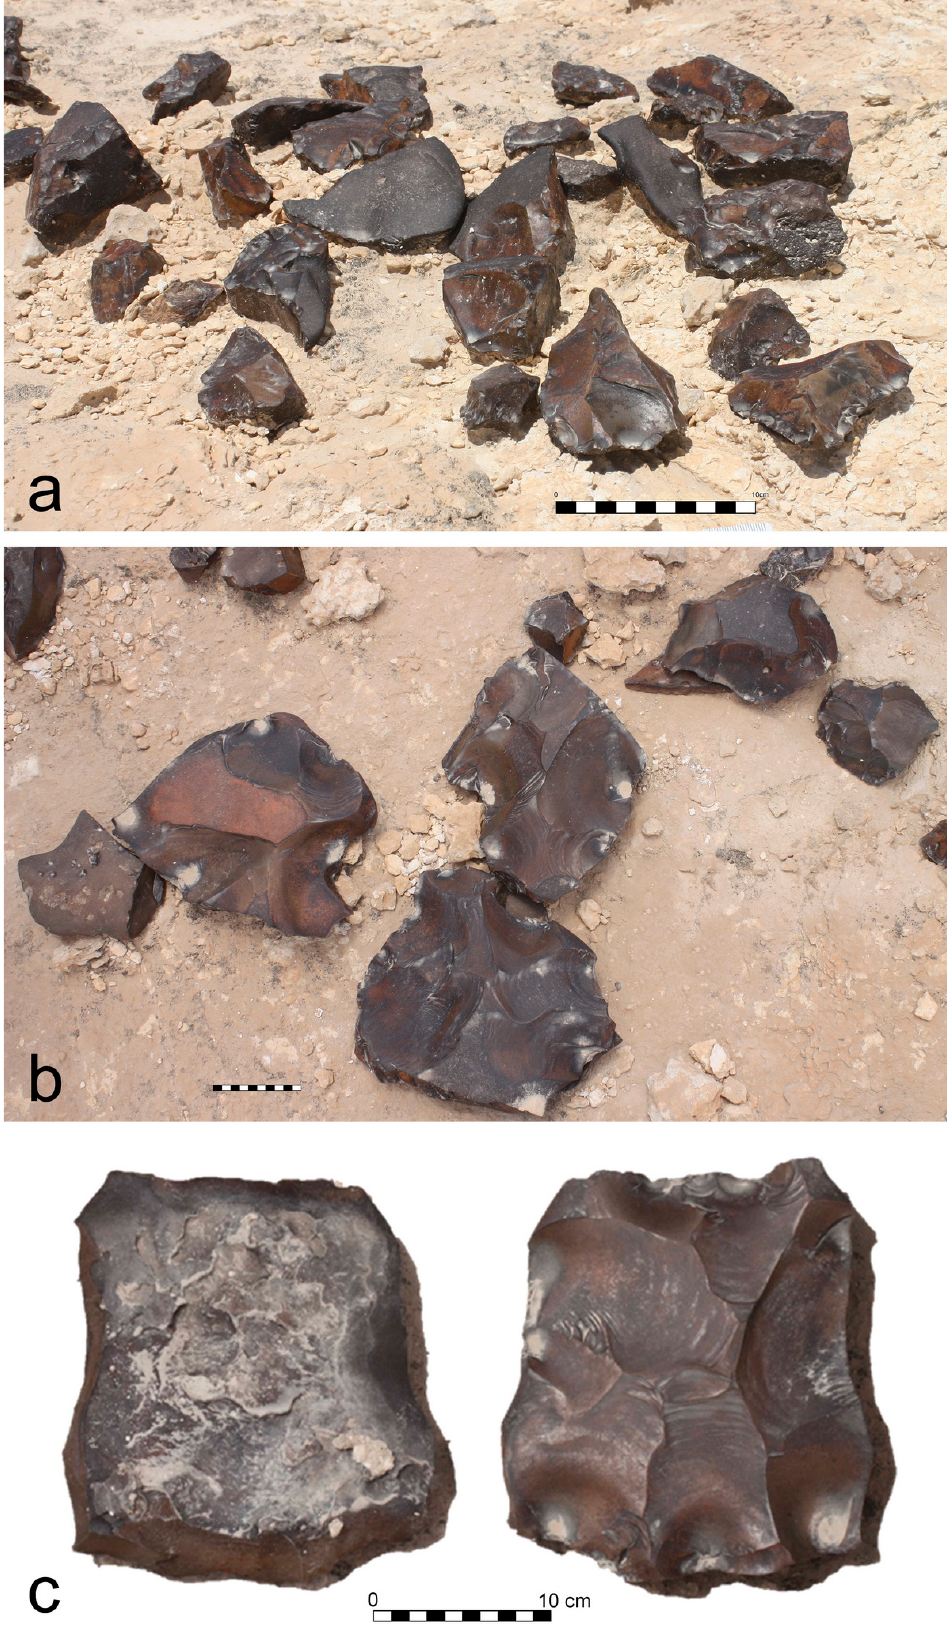
Figure 4. Nahal Zihor 6 a) Close look at one of the artifact concentrations from the Zehiha hills. Notice the Nubian core in the center of photo. b) A second concentration with large Levallois cores on thin flint slabs. c) Large Levallois plaque core. Scale bars are 10 cm wide, divided into 1 cm